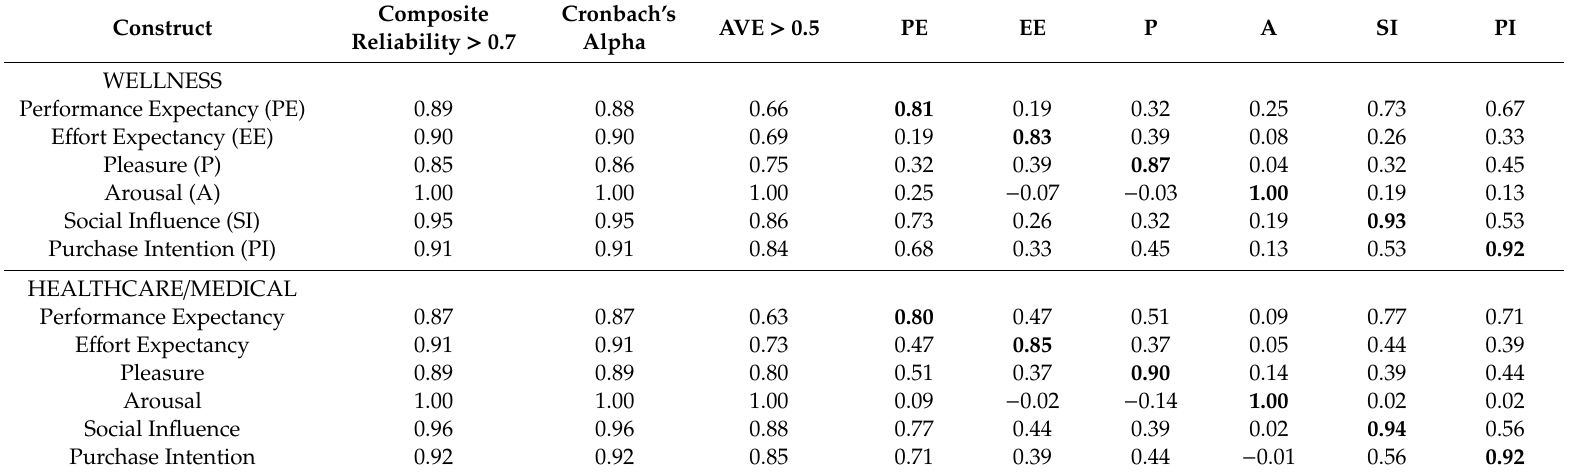
Table 4. Composite reliability, Cronbach’s alpha, average variance extracted (AVE) (convergent validity), and discriminant